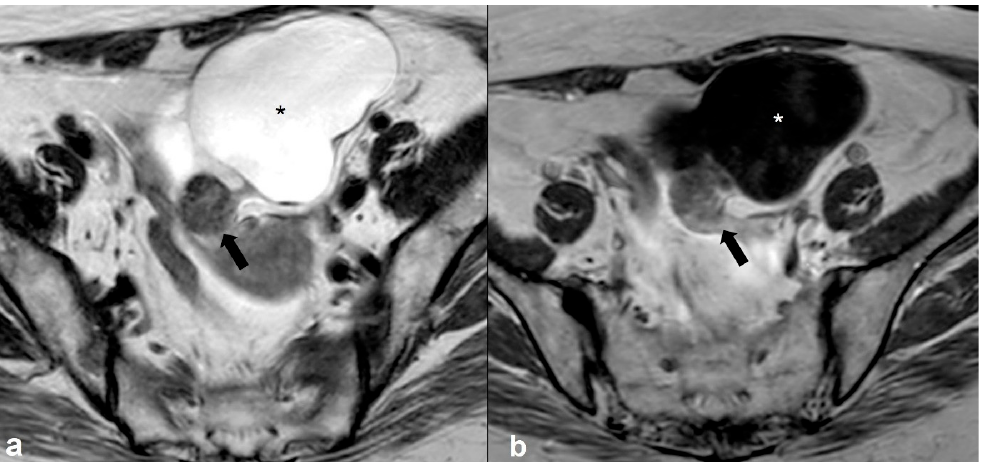
Figure 14. Struma ovarii tumor. Axial T2 weighted image ( a ) shows a predominantly cystic mass (asterisk) with a posteriorly located solid nodule (arrow) in the left ovary showing mild enhance- ment on the T1 weighted contrast-enhanced image (arrows in ( b )) and corresponding to ectopic thyroid